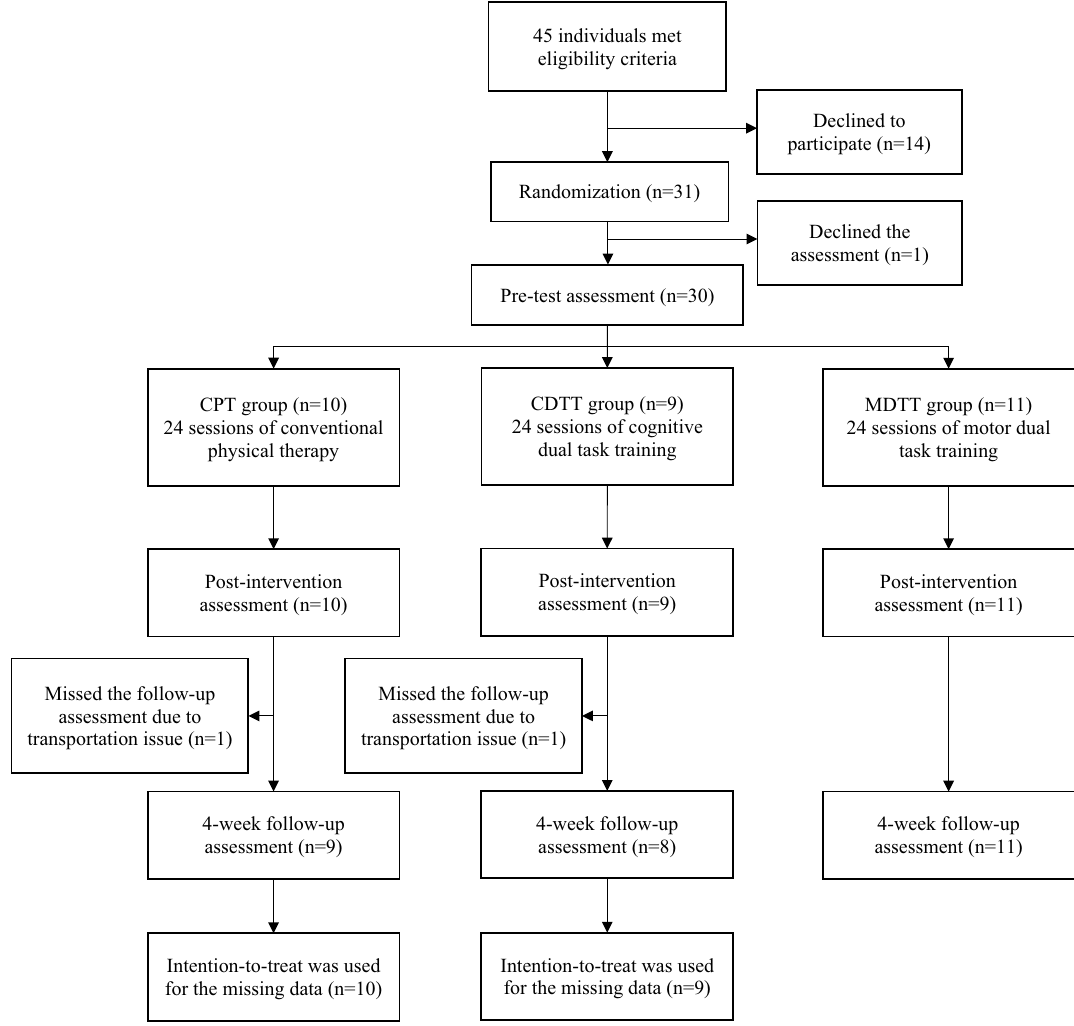
Figure 1. Study flow chart. CPT conventional physical therapy, CDTT cognitive dual task training, MDTT motor dual task training.